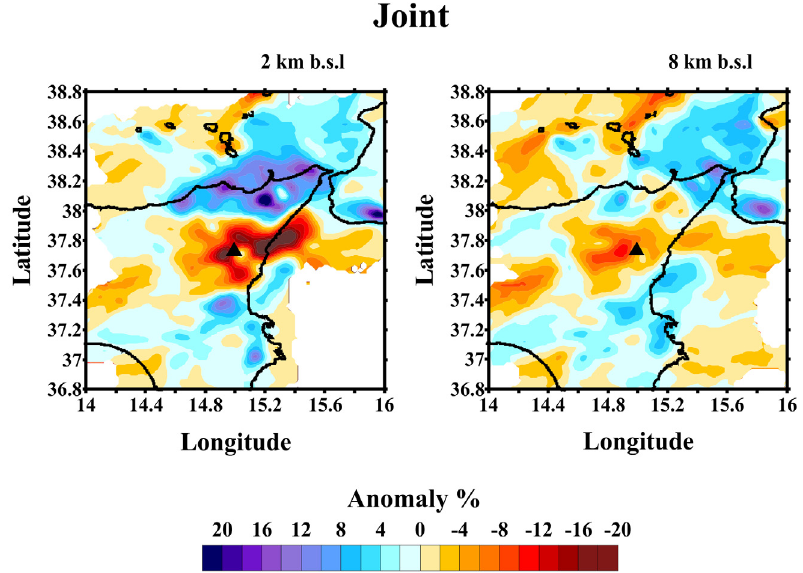
Figure 8. Real data inversion of the TOMO-ETNA joint dataset using a 6-km-spacing grid. Black triangles show the location of Mt.